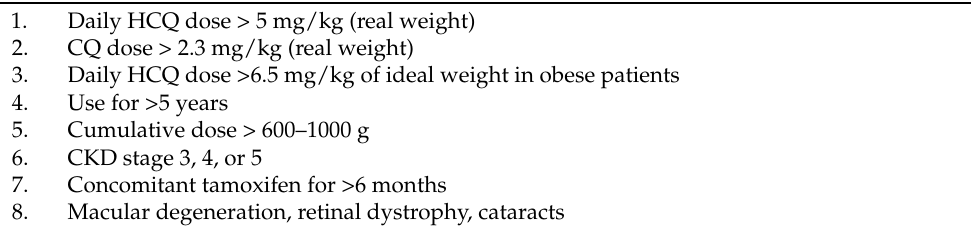
Table 1. Risk factors for antimalarial-induced ocular toxicity